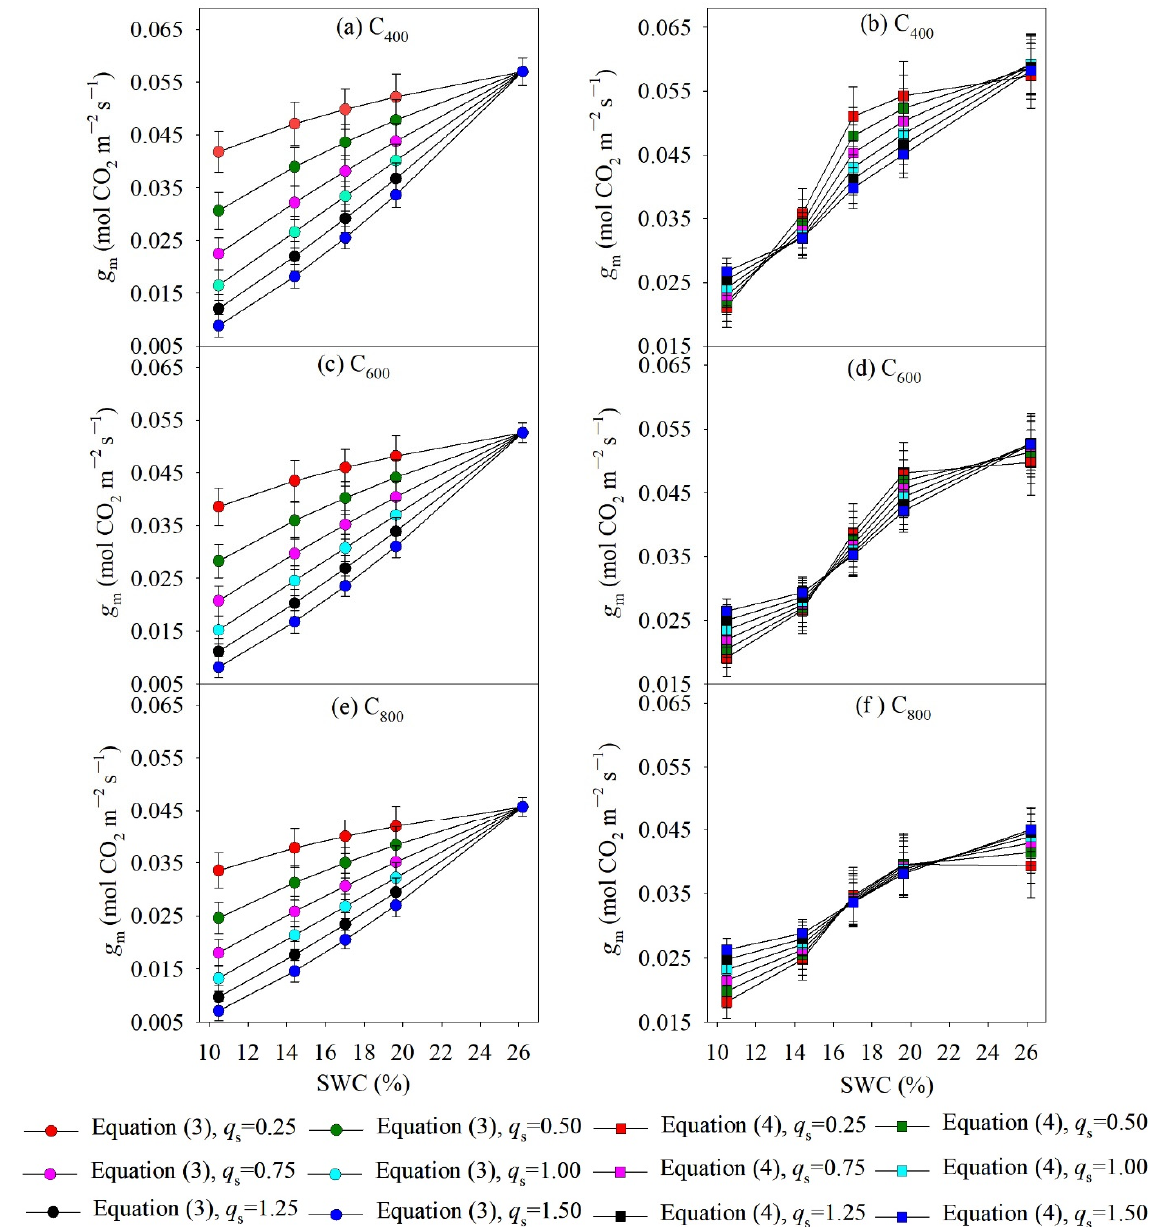
Figure 5. The estimated leaf mesophyll conductance ( g m, mol CO 2 · m − 2 · s − 1 ) is based on different models (Equation (3), ( a , c , e ); and Equation (4), ( b , d , f ) under varying soil water contents (SWC) and CO 2 concentrations ( C a ). C 400 , C 600 , and C 800 are C a of 400 ( a , b ), 600 ( c , d ), and 800 µ mol · mol − 1 ( e , f ). Tunable parameter q m is a measure of the nonlinearity of the effects of soil water stress on the mesophyll limiting mechanisms. Data represent mean values ± SD.